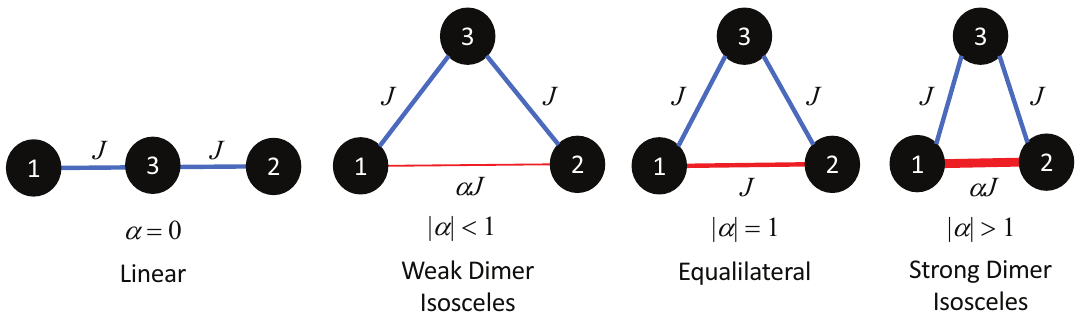
Figure 1. Various magnetic isosceles trimer geometries with different dimer exchanges. Here, two sides of the trimer have an interaction of J , while the third side is a variational dimer exchange of α J . When α = 0, the trimer is linear. However, as | α | is increased the system will produce a weak dimer, equilateral ( α = 1), and a strong dimer ( | α | > 1). It should be noted that the structural geometry is not dependent on the magnetic